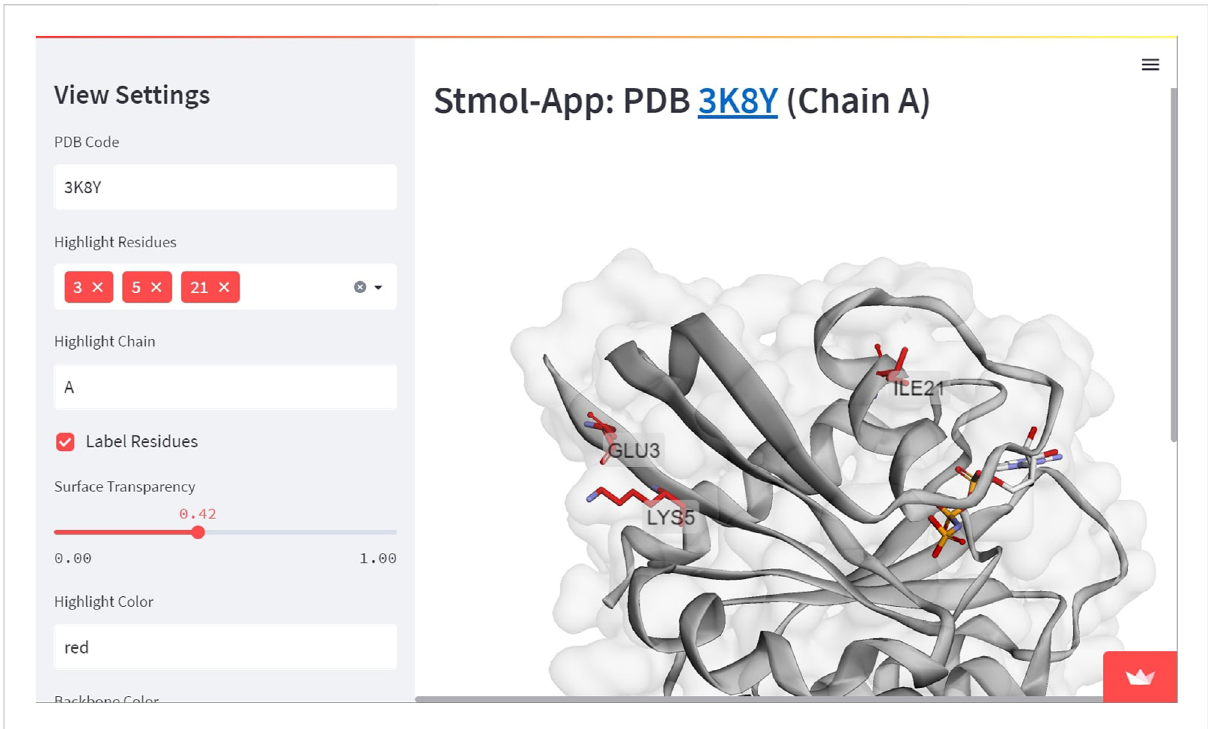
FIGURE 6 Demoapplication.Thisisamoreadvancedexamplewhere residuesarehighlightedandmolecular surfaceisincludedwithtransparency.Inthis case, the user experience is enriched with Streamlit widgets.